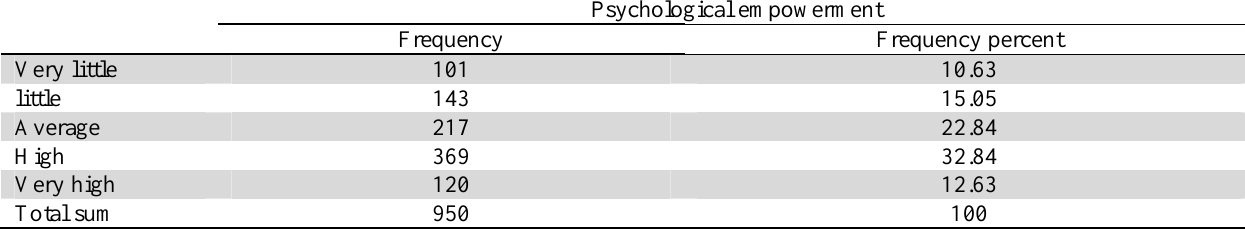
Description of frequency percent of answers to independent variables